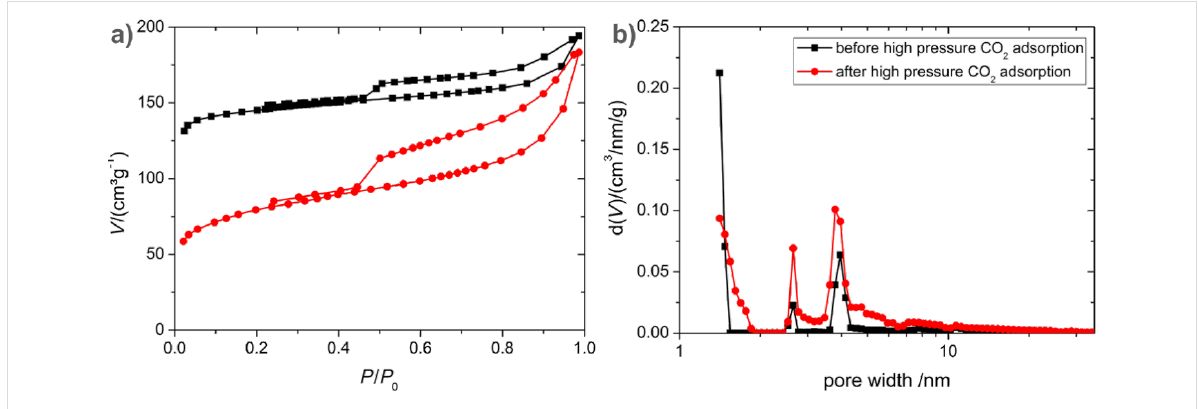
Figure 10: Nitrogen adsorption–desorption isotherms at 77 K (a) and pore size distribution from adsorption (DFT, slit pore model) (b) for carbon tubes ( 4 ) before (black/squares) and after (red/circles) CO 2 adsorption.